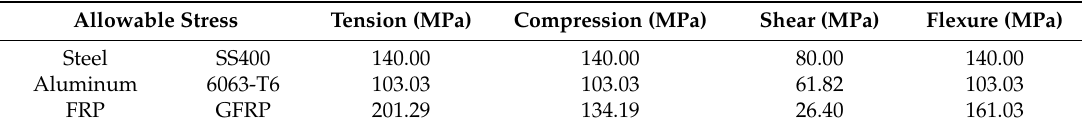
Table 9. Allowable stress of steel, aluminum, and FRP.